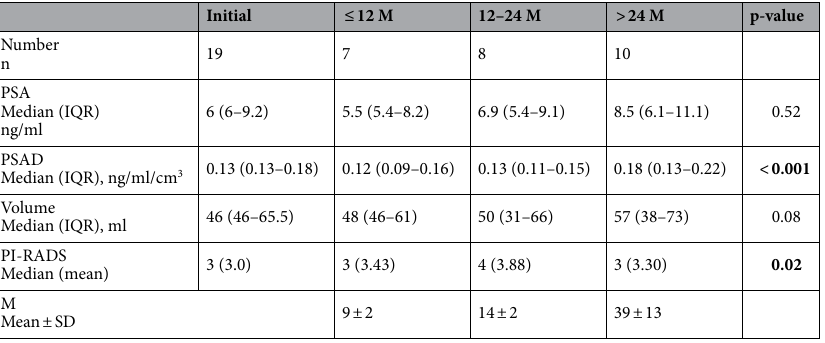
Table 4. Follow up data of patients with PCA. PSA value: prostate specific antigen; PSAD: prostate specific antigen density; PI-RADS: Prostate Imaging Reporting and Data System; IQR: interquartile range; M: months; n: number. Significant values are given in